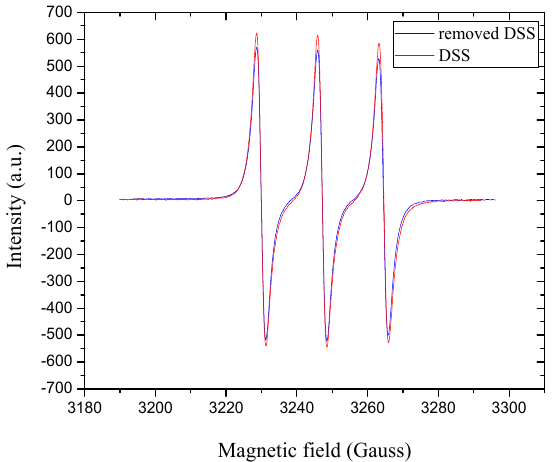
Figure 5. EPR spectra of removed DSS from CSFs / 30%DSS (blue line) and the commercial DSS (red line) in HFIP solution in the presence of TEMPO•.